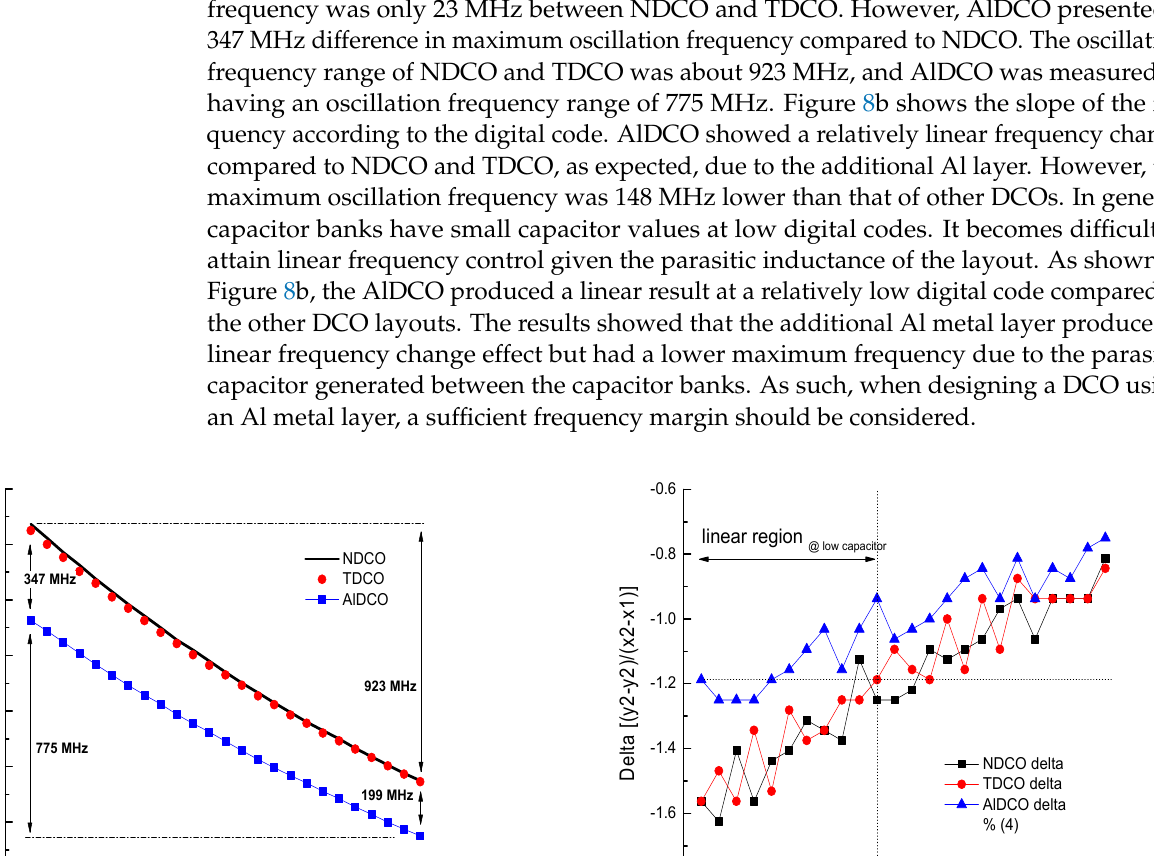
Figure 7. The die photo of the designed DCOs.